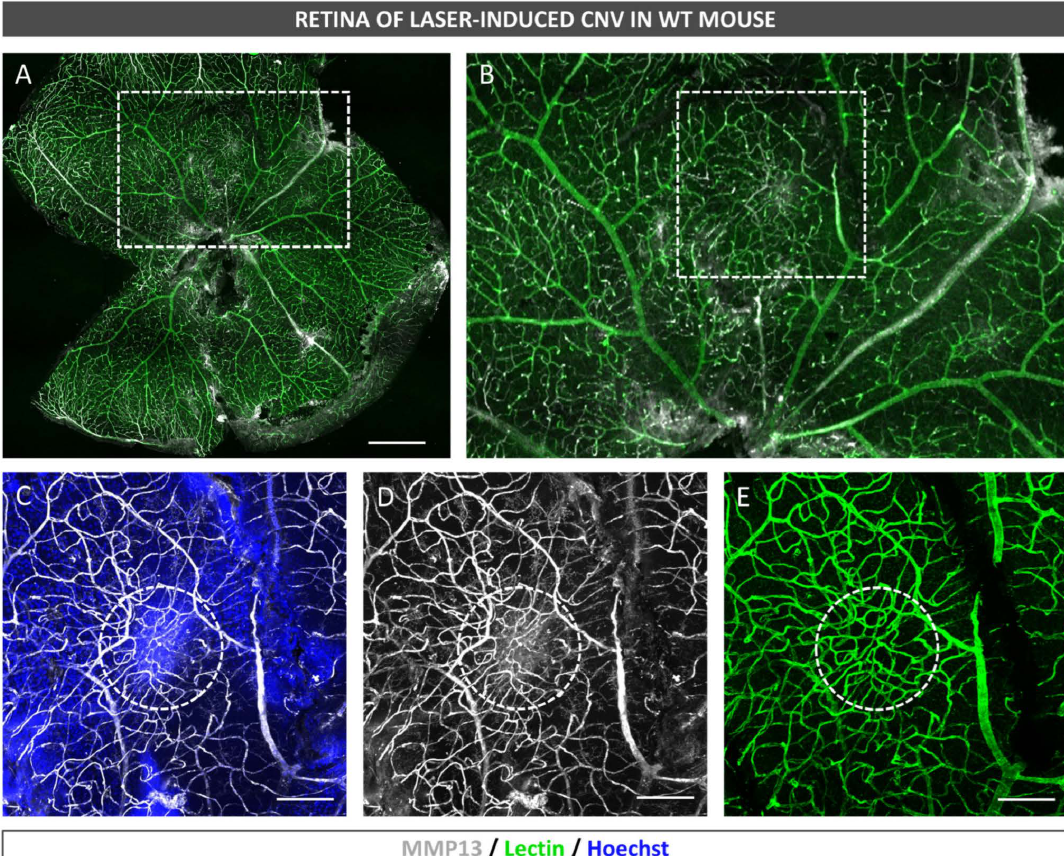
Figure 4. MMP13 expression in laser-induced CNV. WT mouse retina subjected to laser-induced CNV showing MMP13 expression in retinal vessels and diffuse overexpression in retinal parenchyma above the lesions. ( A ) Whole flatmount micrograph; the outlined region represents the magnification shown in ( B ). ( B ) The dotted square represents the magnified area shown in ( C – E ), and the retina overlying the CNV area is located in the center (dotted circle). ( C ) MMP13-positive retinal vessels and a cluster of nuclei (blue) above the CNV (dotted circle). ( D ) The cluster of cells shown in ( C ) showed MMP13 expression. ( E ) Retinal vessels positive for lectin (green). n = 8. Hoechst 33342-labeled nuclei, blue; lectin, green; and MMP13, white. EC = endothelial cells. CNV = choroidal neovascularization. MMP13 = matrix metalloproteinase 13. ON = optic nerve. WT = wild type. Scale bars: 500 µ m ( A ), 100 µ m ( C – E